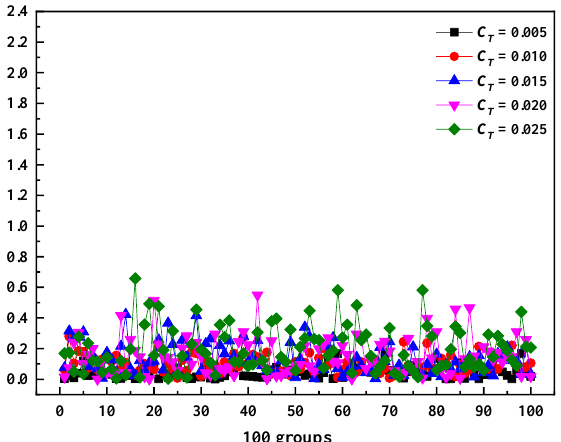
Figure 17. Center concentration deviation under the different relative standard deviations of temperatures at velocity 5.05 m/s.